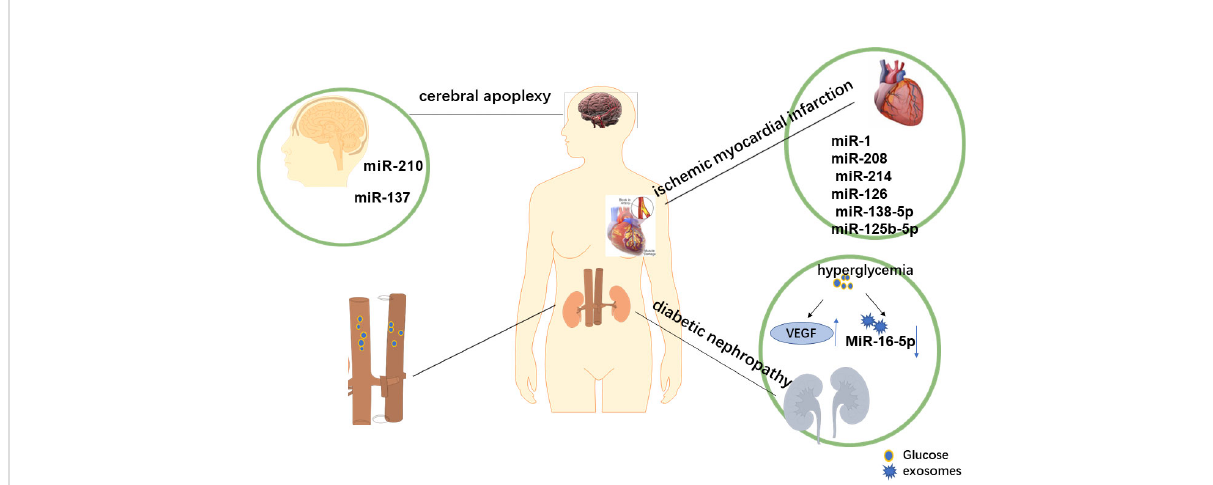
FIGURE 3 Exocrine-related complications of diabetes. During the development t of diabetes mellitus, changes in the microenvironment also lead to alterations in exocrine bodies, which are involved in cardiovascular and cerebrovascular risk events, such as diabetic nephropathy, myocardial infarction, and stroke. Ever-increasing evidence suggests that the level of exosomes in the blood of patients with diabetes is elevated and is involved in the pathophysiology of diabetes-related diseases. Therefore, we concluded that the overexpression and downregulation of speci fi c miRNA might be a new method to treat diabetes and its related